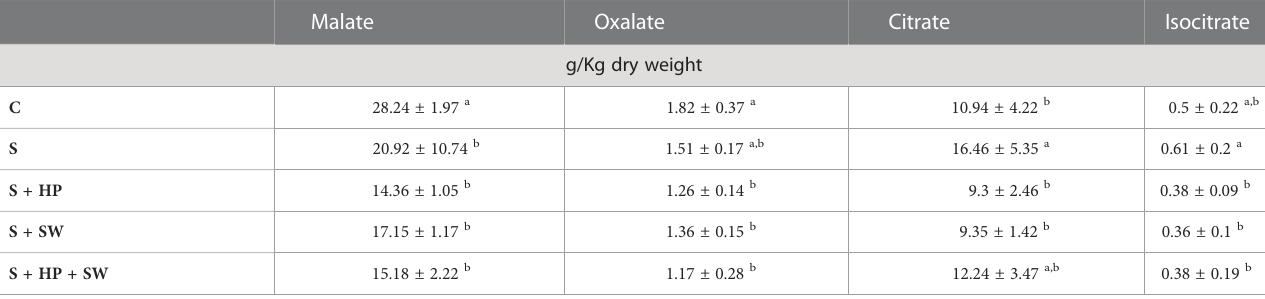
TABLE 2 Total organic acids concentration of tomato leaves grown under salinity stress (S) and treated with biostimulants i.e., protein hydrolysate (PH), seaweed extracts (SW), and their combination PH + SW, compared to the control non-stressed plants